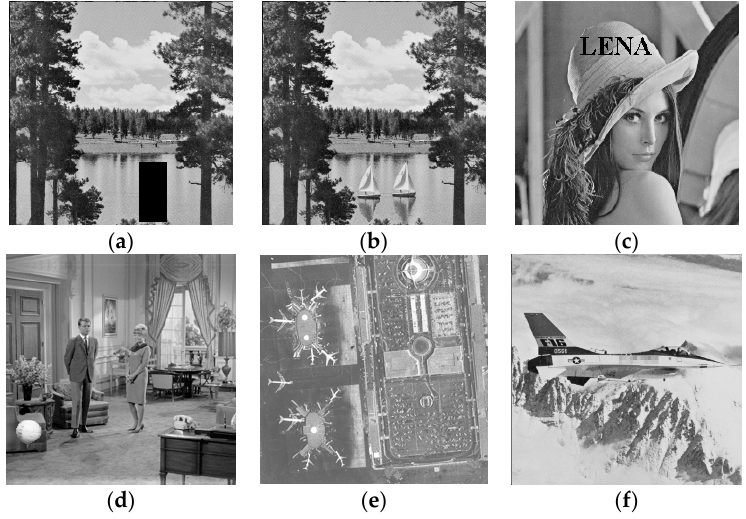
Figure 7. Tampered images: ( a ) Image cropping; ( b ) Copy–paste attack; ( c ) Text addition; ( d ) Collage attack; ( e ) Content-based attack; ( f ) Constant-average attack.